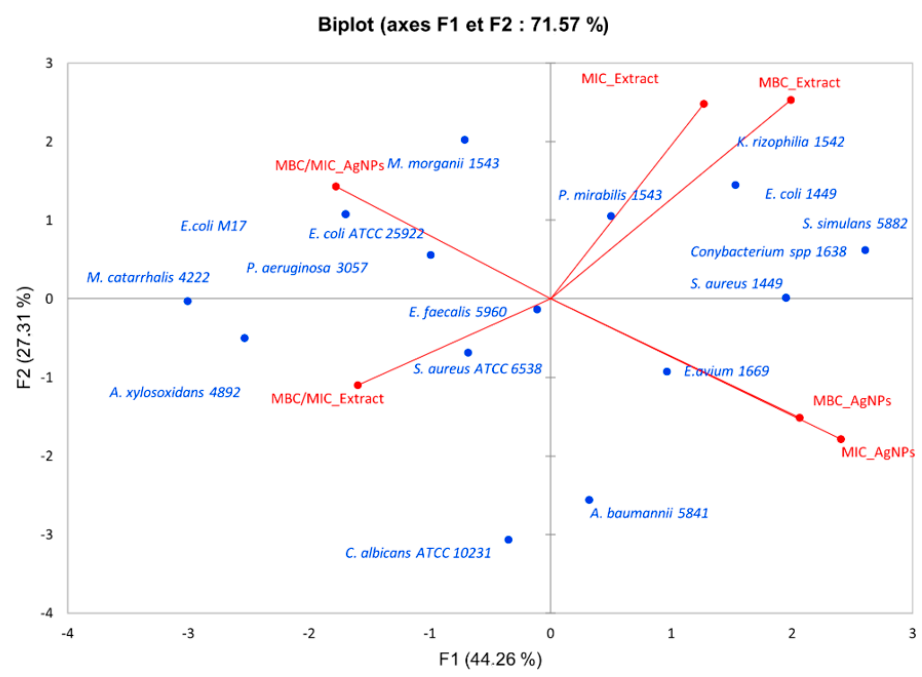
Figure 7. PCA analysis of MIC, MBC, and ratio MBC/MIC of optimized ethanolic extract of E. chlorantha bark (O-ECB) and green-synthetized AgNPs against various